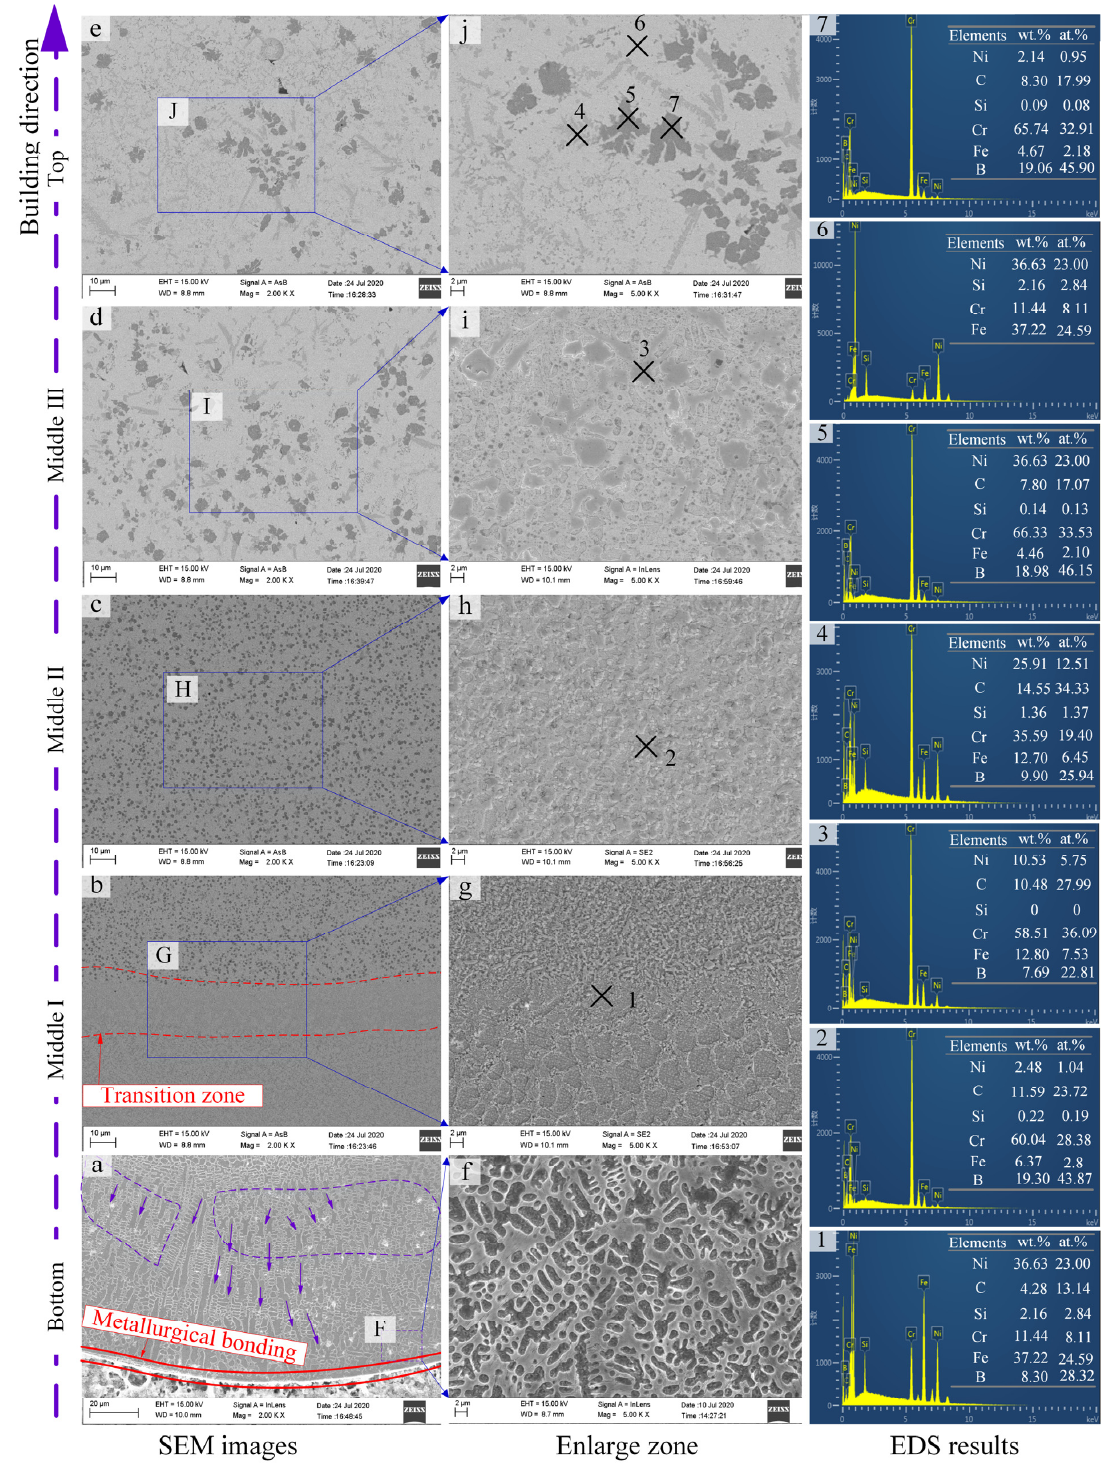
Figure 15. The cross-section micrographs and EDS image of the whole gear teeth.